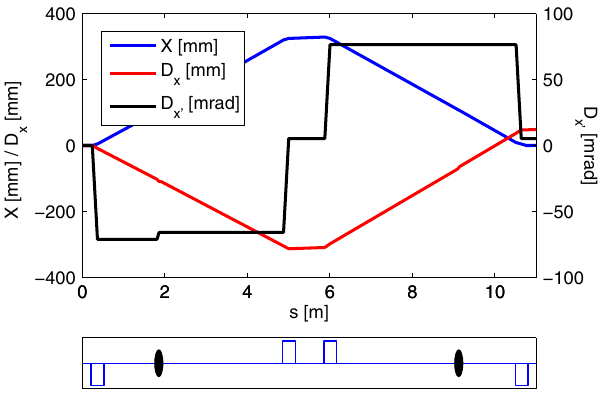
FIG. 4. Horizontal dispersion generation. Calculated absolute horizontal trajectory and dispersion functions through the bunch compressor when the first quadrupole in the bunch compressor has an integrated normalized gradient of 0 . 05 m − 1 . The lower plot shows a sketch of the bunch compressor: the blue rectangles correspond to the dipole magnets and the black ellipses corre- spond to the quadrupoles.